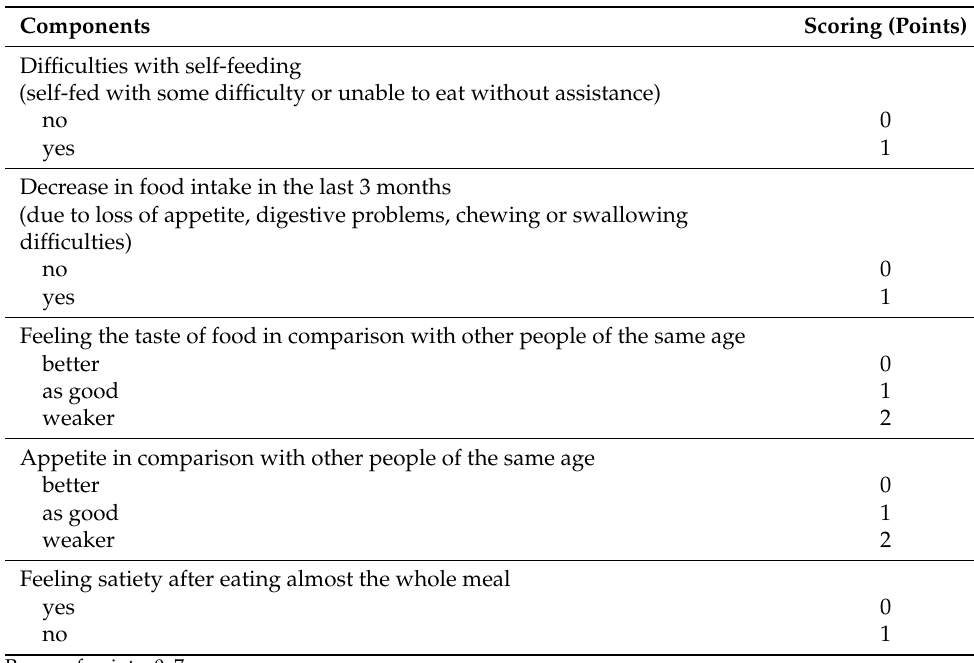
Table 2. Eating-related Limitations Score (E-LS)—components data and